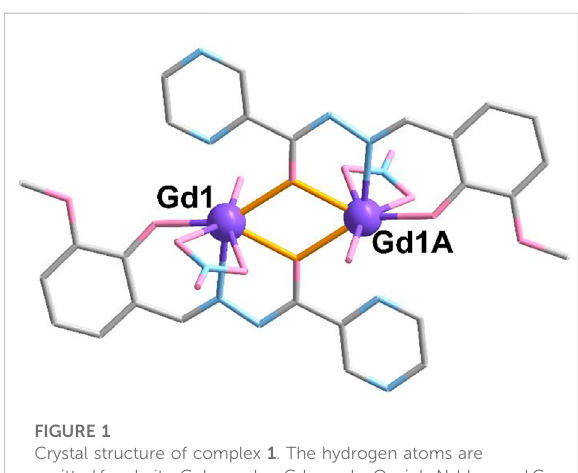
FIGURE 1 Crystal structure of complex 1 . The hydrogen atoms are omittedforclarity.Colorcodes:Gd,purple;O,pink;N,blue;andC, grey. Symmetric code: A, 1-x, 1-year, and